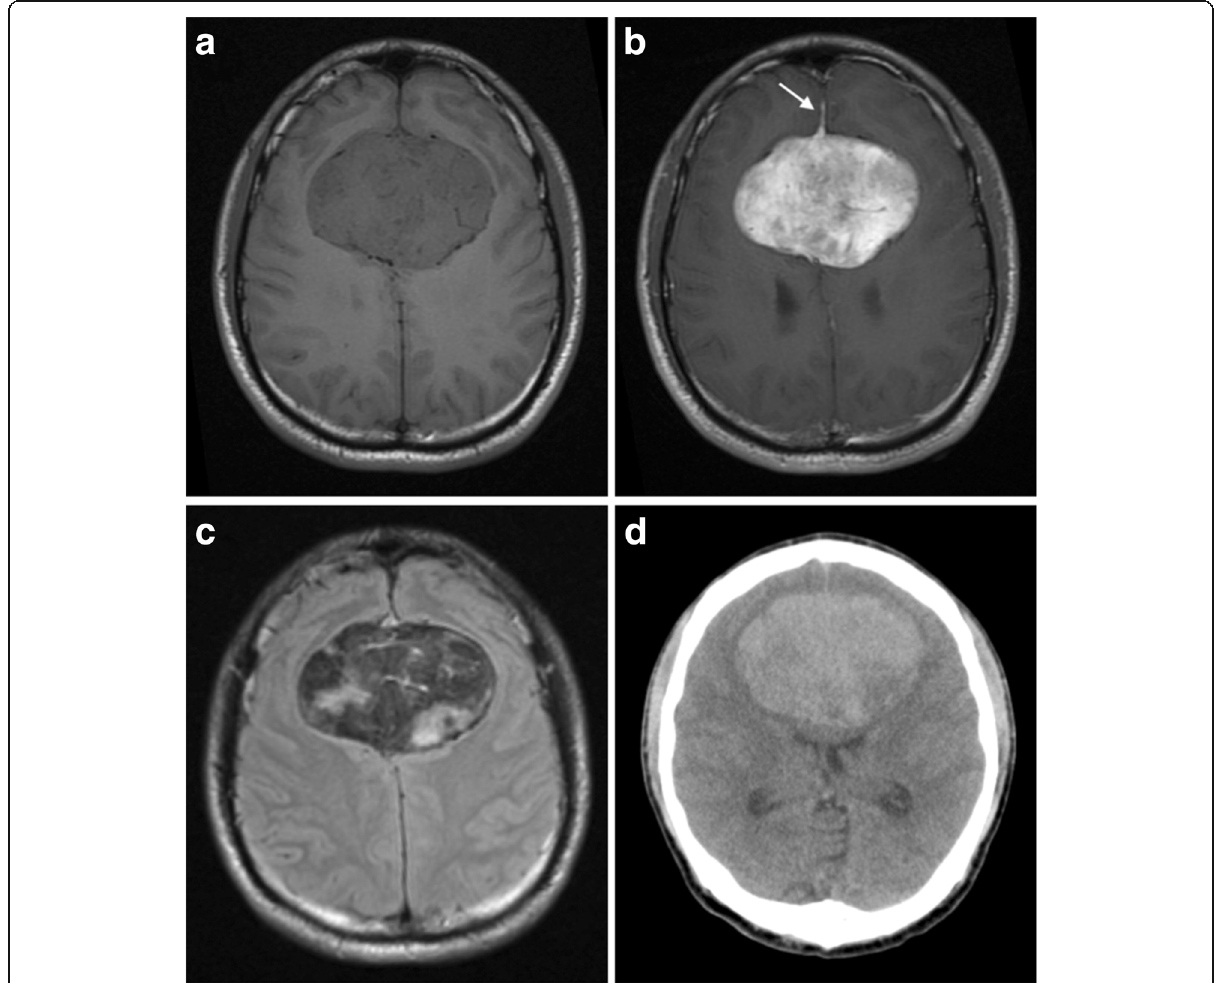
Fig. 7 Solitary fibrous tumour. a , b Pre- and post-contrast axial T1-weighted MR images showing an avidly enhancing extra-axial lesion straddling the falx cerebri. An enhancing dural tail is seen anteriorly (white arrow). c On T2 FLAIR images, the lesion has regions of high and low signal consistent with its fibrous collagen composition. Note how these low signal regions enhance with administration of contrast in Fig. 7b. d On unenhanced CT images, the mass is largely hyperdense with no areas of